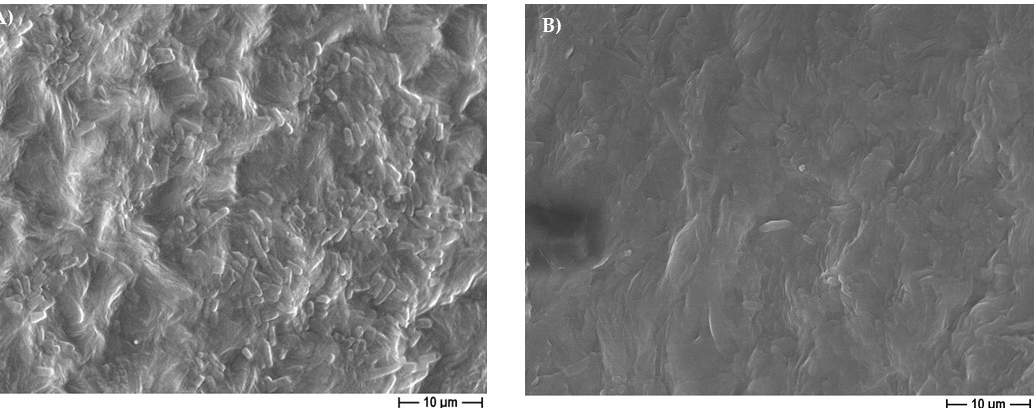
Figure 13. Representative FESEM micrographs regarding E. coli presence on non-sonicated PCL- based scaffolds ( A ) and 30% eugenol-added PCL-based scaffolds ( B ), obtained by using NaCl salt as a template, at 2000× magnification.